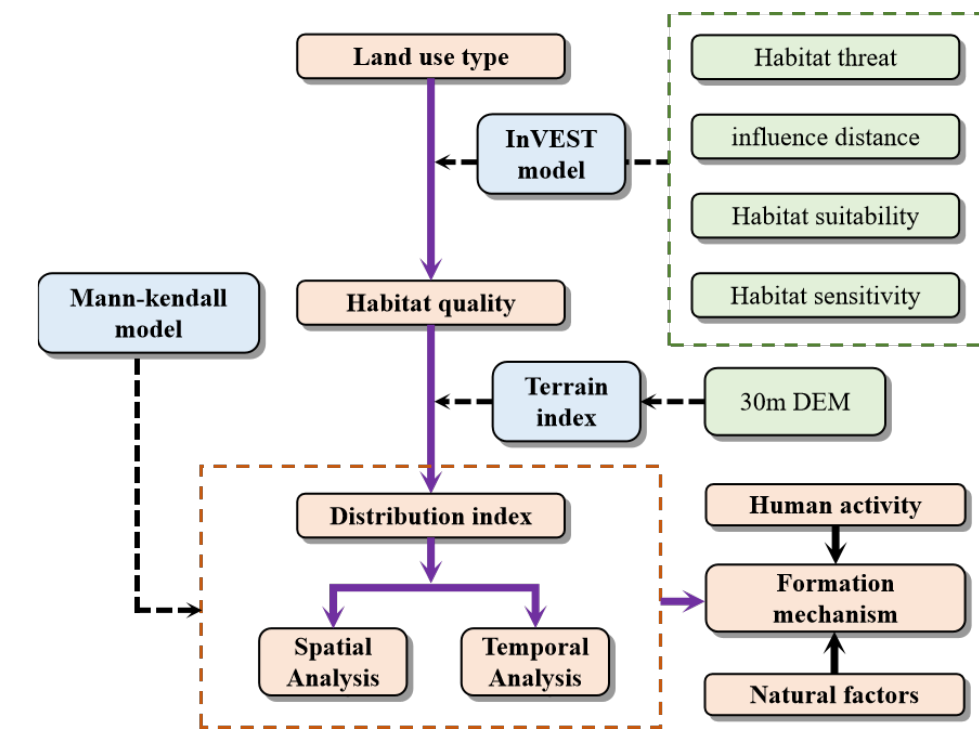
Figure 2. Technical